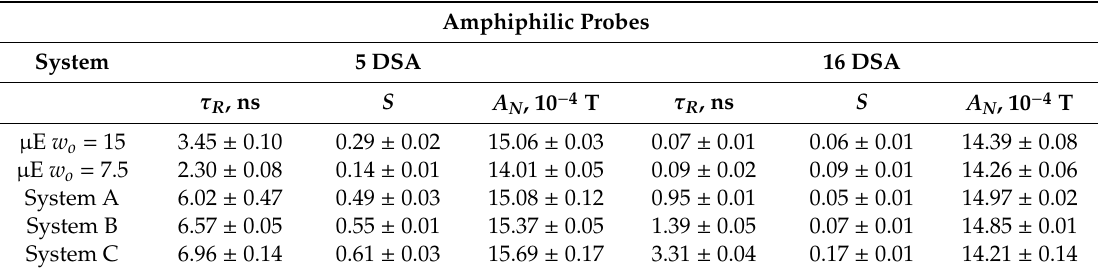
Table 3. τ R , S , and A N values of amphiphilic spin-probes 5-doxyl stearic acid (5-DSA) and 16-doxyl stearic acid (16-DSA) in AOT microemulsion ( µ E) and HPMC